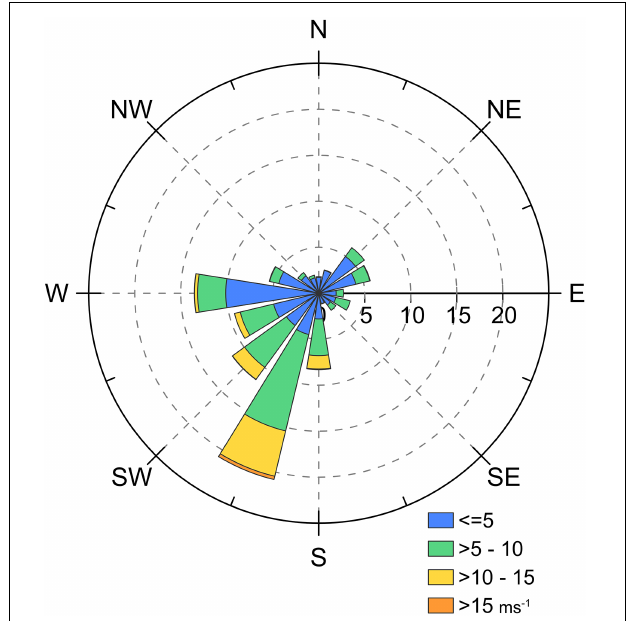
FIGURE 5 | Wind rose indicating average wind speed and direction during the period from 26 January to 21 March 2018.